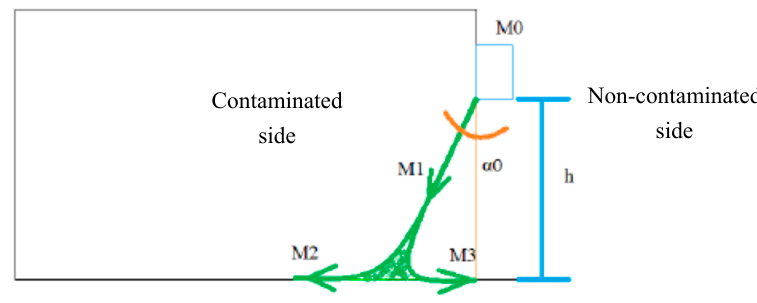
Figure 2. Cross section of the plane jet system.